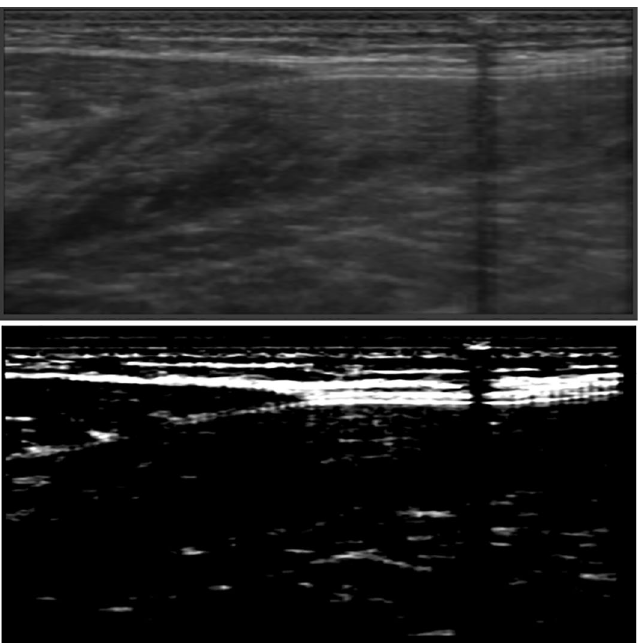
Figure 5. Example of ultrasound image before (top) and after (bottom) post-processing in